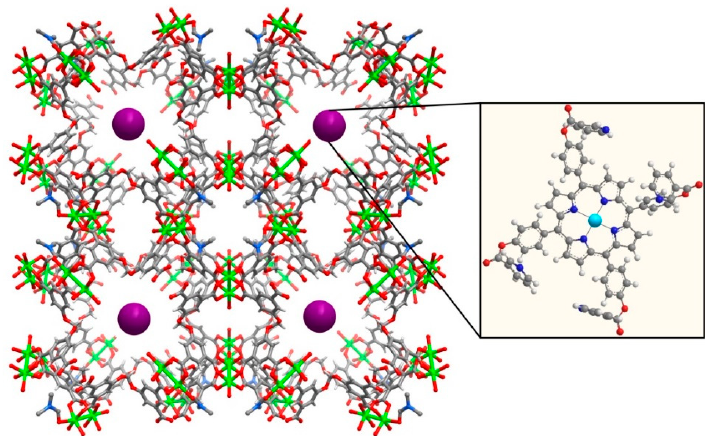
Figure 10. Schematic representation of porphyrin@MOFs type-catalysts. (Colour scheme: bright green = Cu, gray = H, dark gray = C, light blue = N, red = O, sky blue = metal in the porphyrin core, purple = porphyrin representation).